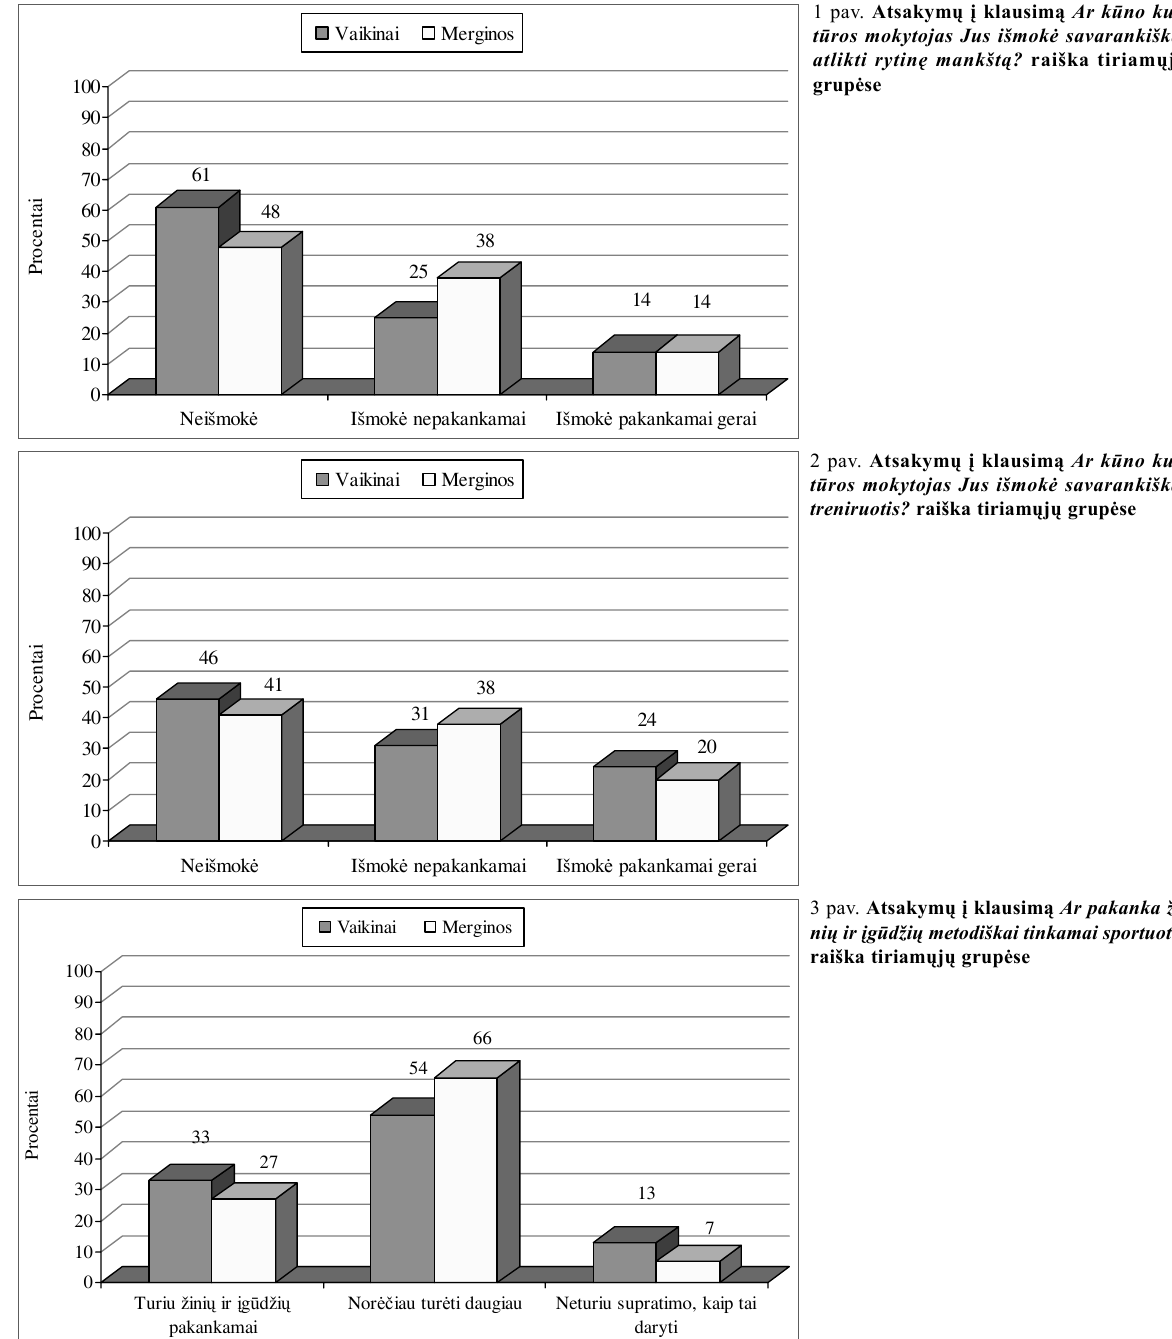
Daugiausia vaikin ų savarankiškai sportuoja po 2 h per savait ę (46%), mergin ų šis rodiklis statis- tiškai patikimai mažesnis (p < 0,05) (2 lent.). Po 3 h per savait ę mergin ų sportuoja taip pat mažiau, o po 4 h per savait ę — mergin ų tik 11%, vaikin ų 29%. Tai rodo, kad gana didel ė dalis vaikin ų skiria